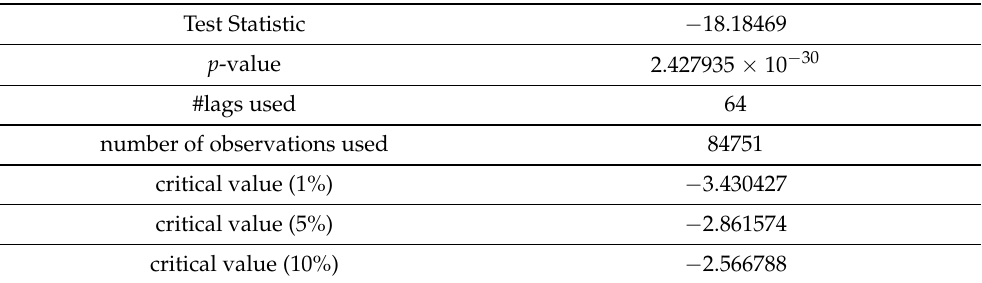
Table 3. ADF test result for the full